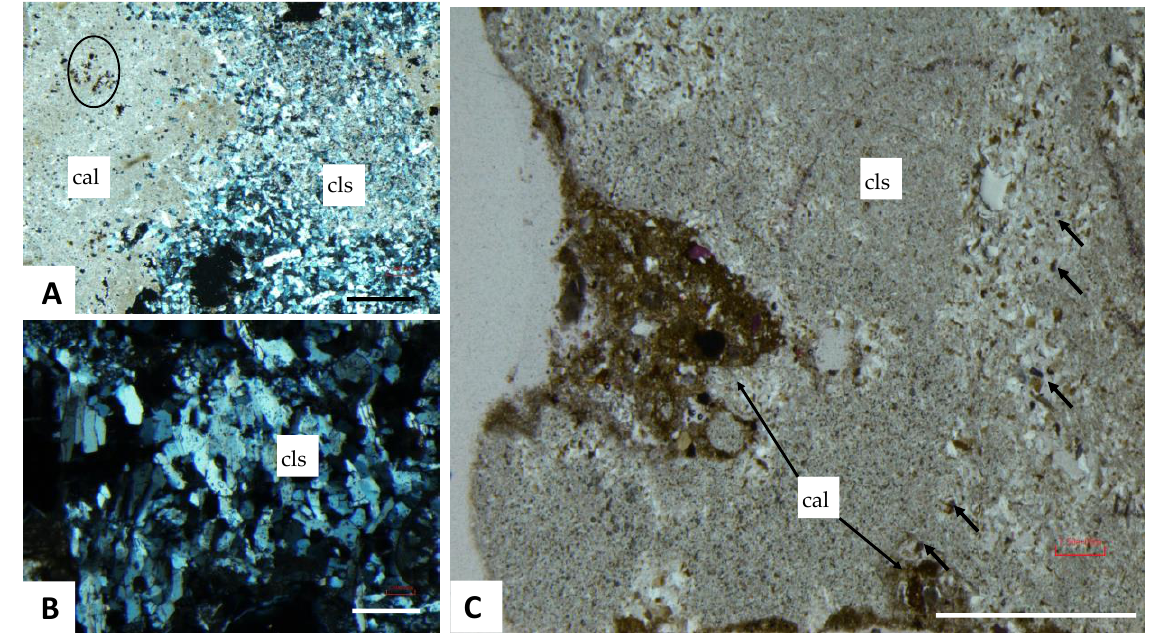
Figure 2. Optical microscopy. ( A ) Representative image with cross-polarized illumination showing micro sparite calcite matrix (cal) and massive celestine (cls) aggregates of prismatic crystals. Circle indicates presence of iron oxides and hydroxides. ( B ) Image of high-grade mineral (E92) made of larger prismatic celestine crystals filling in large synsedimentary voids (desiccation cracks and evaporite molds). ( C ) Representative image of prewashed medium-grade mineral sample (E69) showing areas with massive calcite (cal) and celestine (cls) aggregates. Calcite matrix demonstrates a darker brown color, whereas celestine has a lighter color. There are disseminated dolomite crystals (arrows) that are stained blue with ferricyanide. Scale bar: 100 µm.